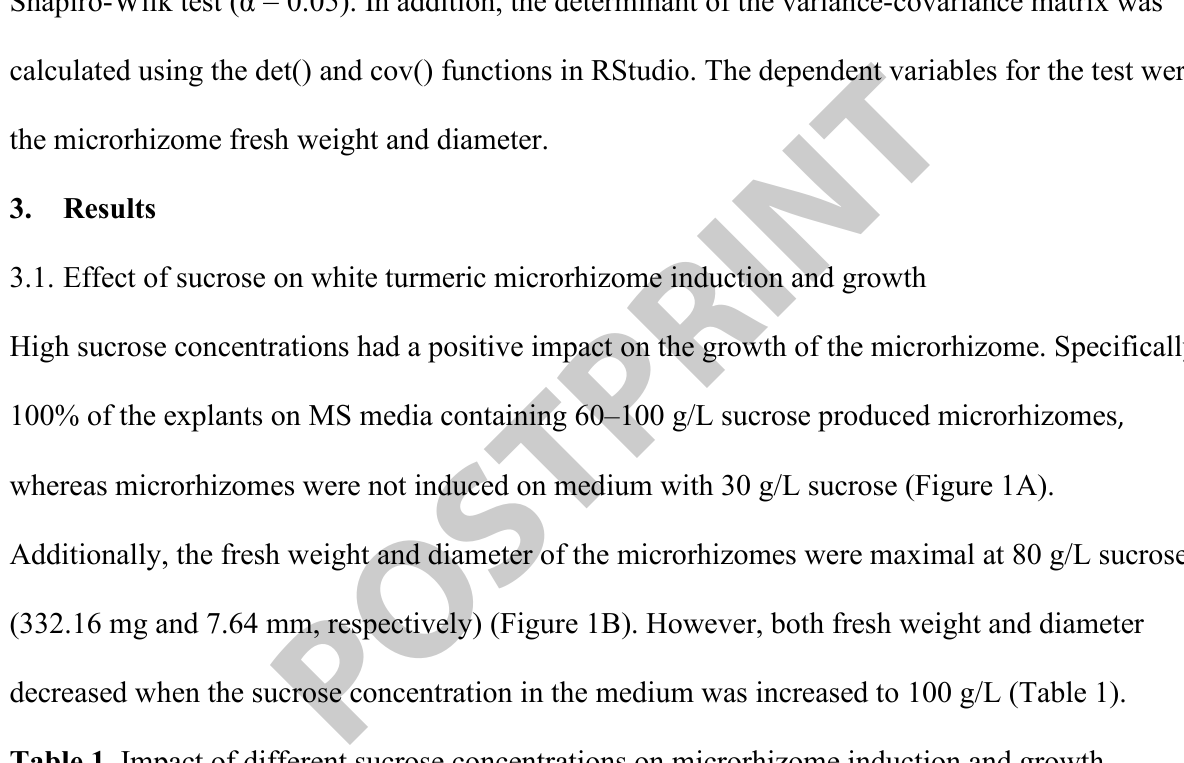
Table 1. Impact of different sucrose concentrations on microrhizome induction and growth Sucrose concentrations